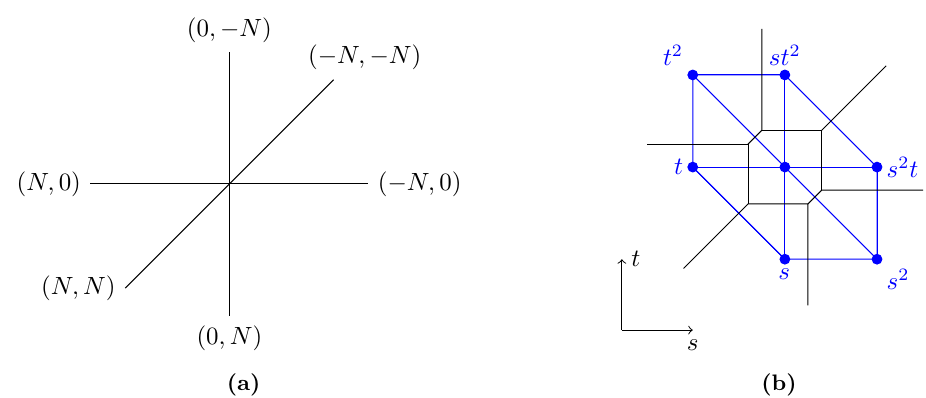
Figure 7. Left: the sextic junction describing the (cid:30) + N theory. Right: brane web and grid diagram for a deformation of the (cid:30) + 1